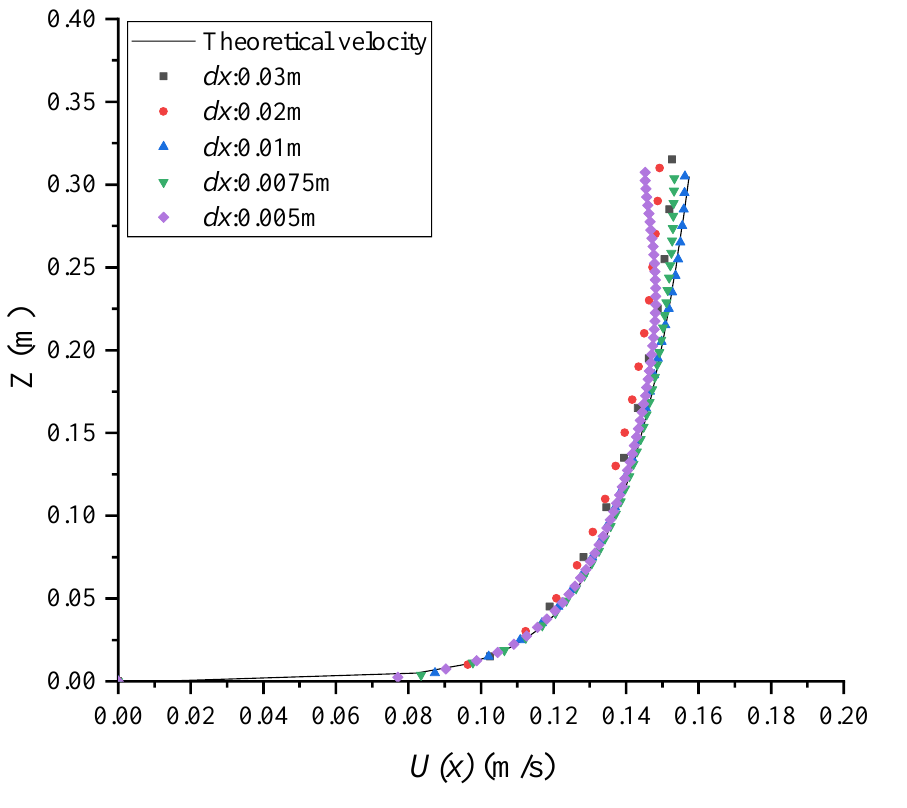
Figure 4. Verification of mesh independence.